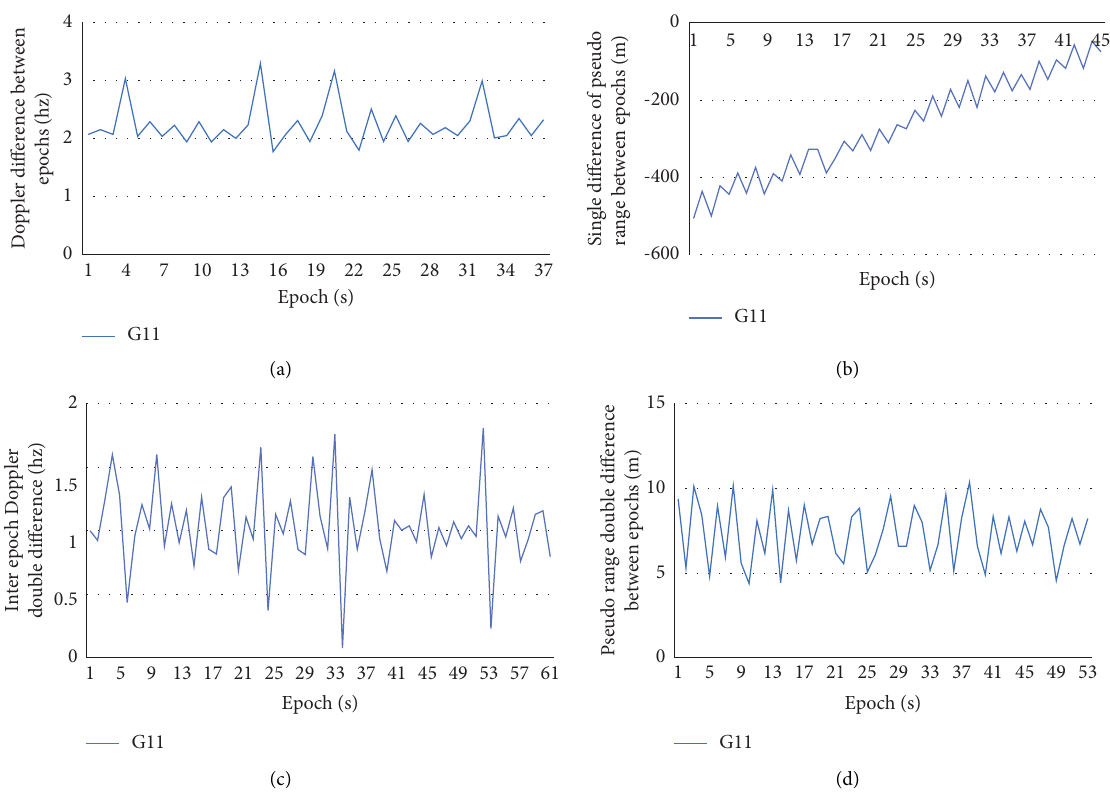
Figure 4: Doppler diference and pseudorange diference between ephemeris elements of the G11 satellite. (a) Doppler single diference. (b) Pseudorange single diference. (c) Doppler double diference. (d) Pseudorange double diference.